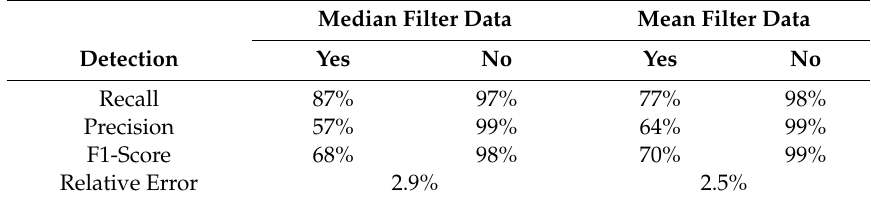
Table 7. Classification results for the validation dataset (average of all generated classifiers).